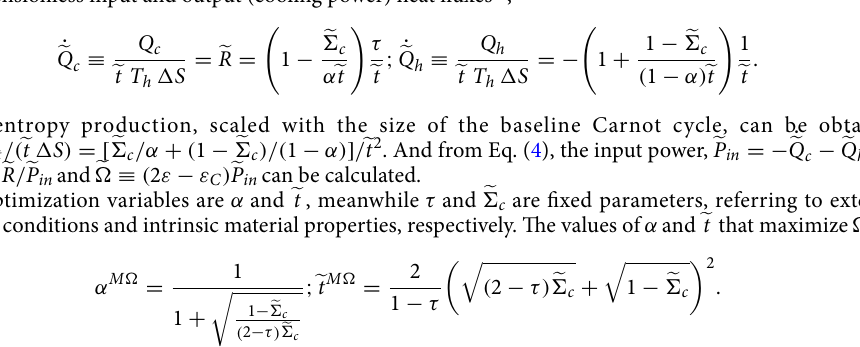
T c / T h . Upper and lower bounds are obtained in ≡